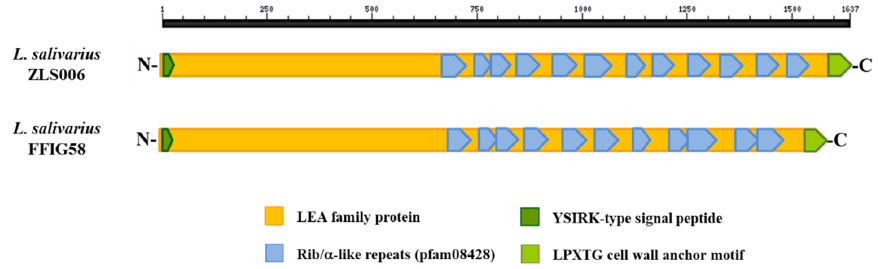
Figure 12. Comparison of the domain organization in the LEA family adhesin from Ligilactobacillus salivarius FFIG58 isolated from the intestinal mucosa of wakame-fed pigs and the porcine strain L. salivarius ZLS006.